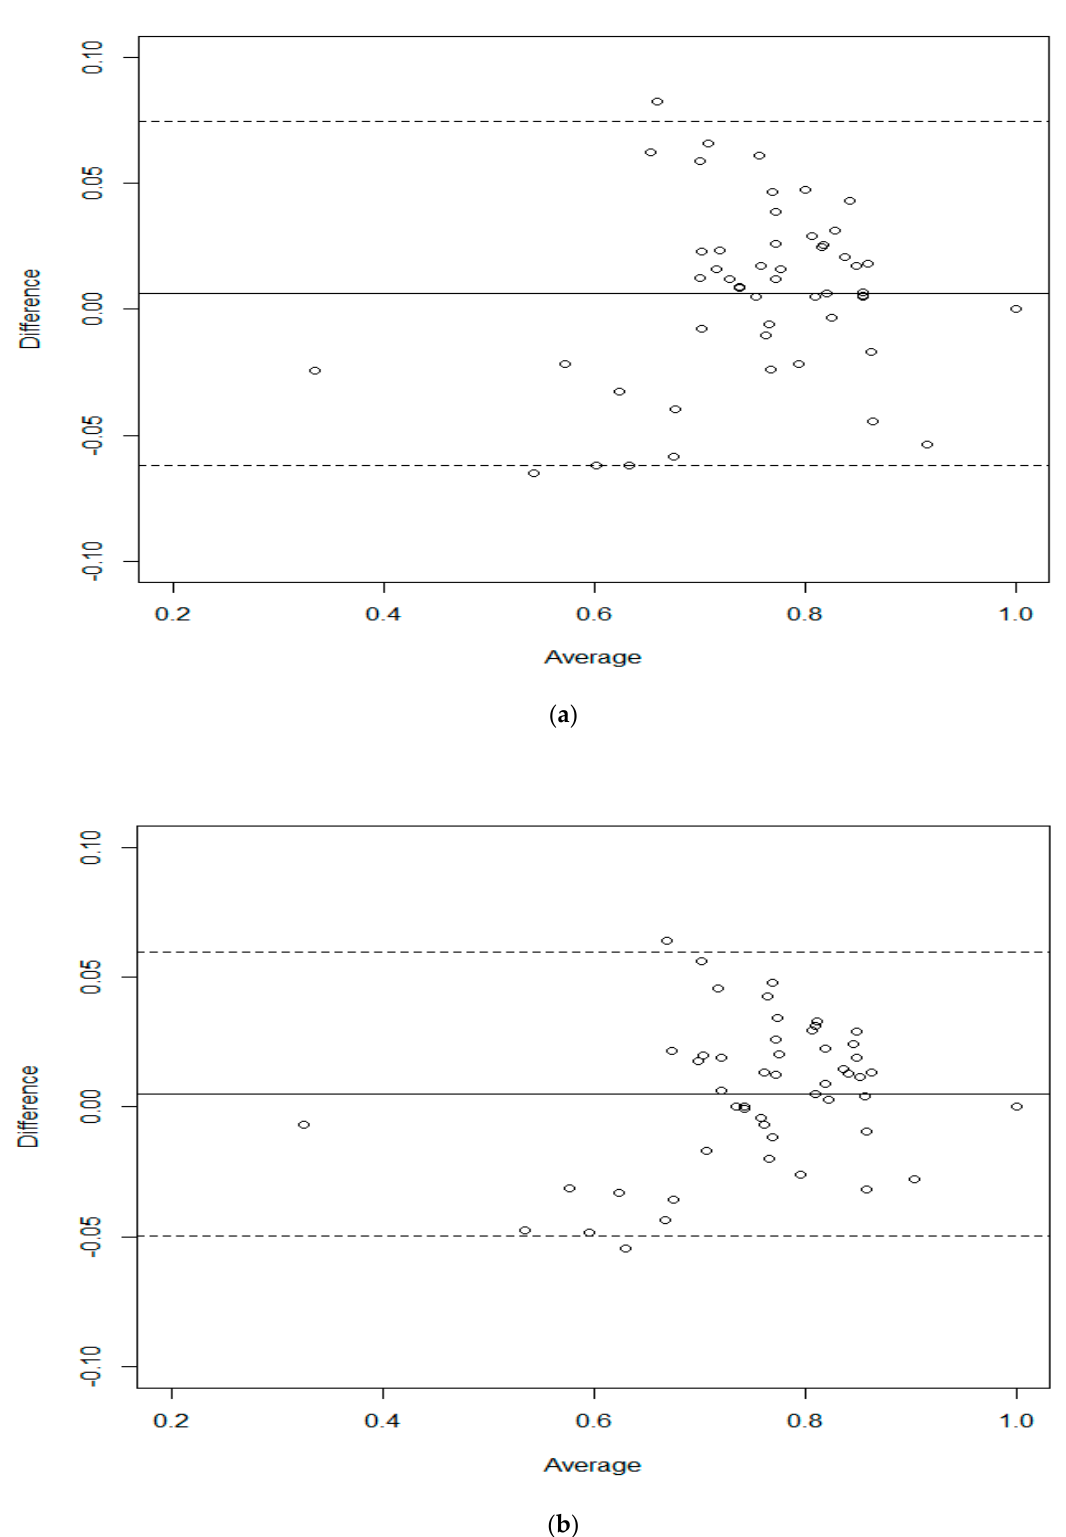
Figure 2. Bland–Altman plot for ( a ) the crude model and ( b ) model (1). The inferences for the utilities of the 49 SF-6D states in addition to the full health are displayed in Table 1. The observed mean utilities of the Lebanon data are displayed in